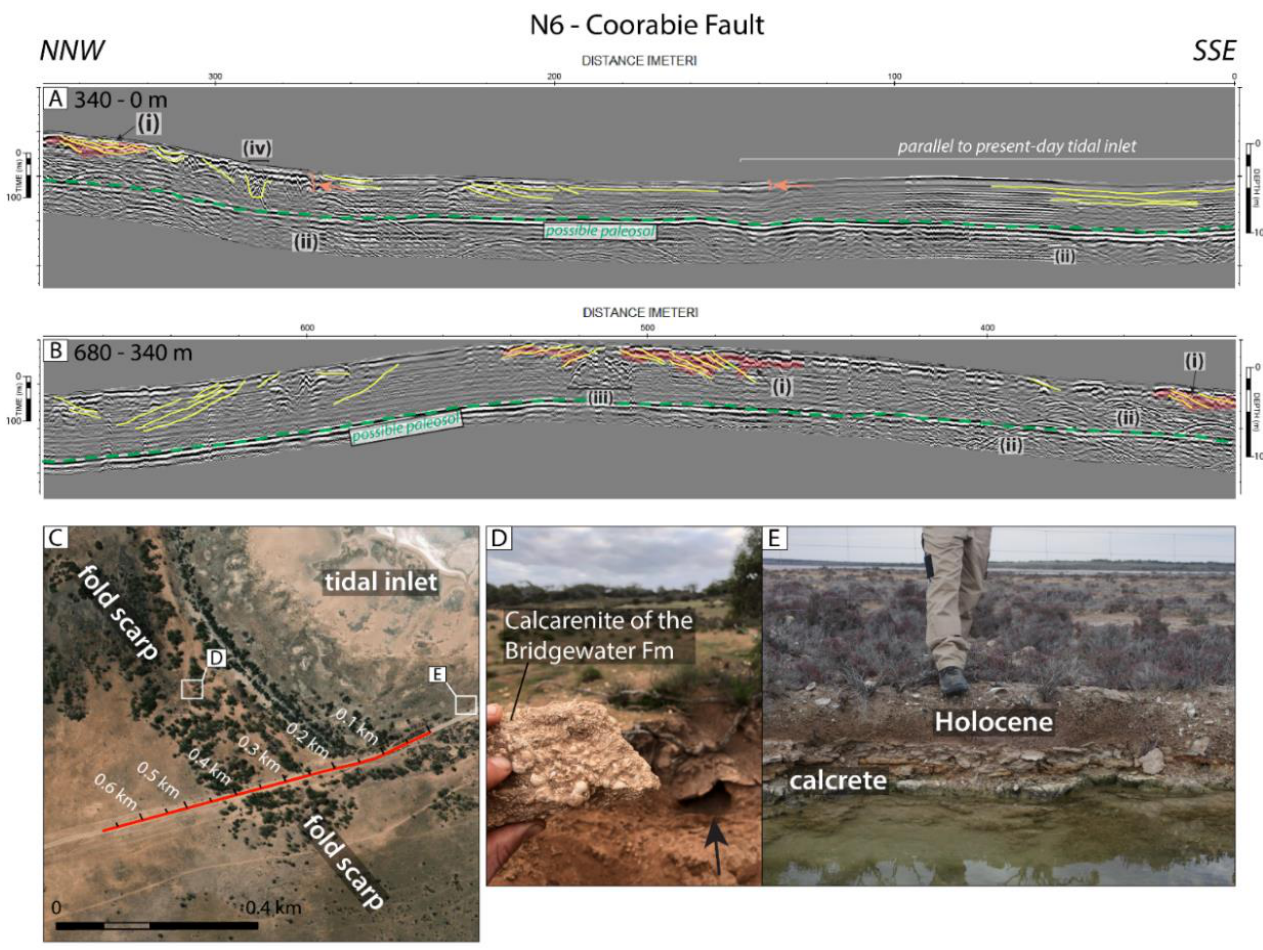
Figure 9. ( A , B ) GPR transect N6. Interpreted reflectors within the Bridgewater Formation are shown in yellow; (i): zones with strong, discontinuous reflectors, interrupted by diffractions originating from knobbly calcrete; (ii): wide hyperbolas indicating airwave reflections from vegetation; (iii): possible trench producing ‘ringing’ at the edges and hyperbolic diffractions from infill, visible in Orthophotos; (iv): possible trench fill; ( C ) Orthophoto showing location of the transect (red line) in relation to the fold scarp and the adjacent tidal inlet, the locations of the photos in ( D , E ) are indicated; ( D ) Sample of calcretized calcarenite from the Bridgewater Formation. The background of the photo, taken on the slope of the scarp, shows a wombat burrow (black arrow) dug into the uncalcretized deposits of the Bridgewater Formation, below the calcretized surface; ( E ) Cross section in a roadside trench showing the calcretized Holocene deposits of the Le Hunte Member (gypsiferous lacustrine sediments of coastal, saline lakes [69]) within the tidal inlet.